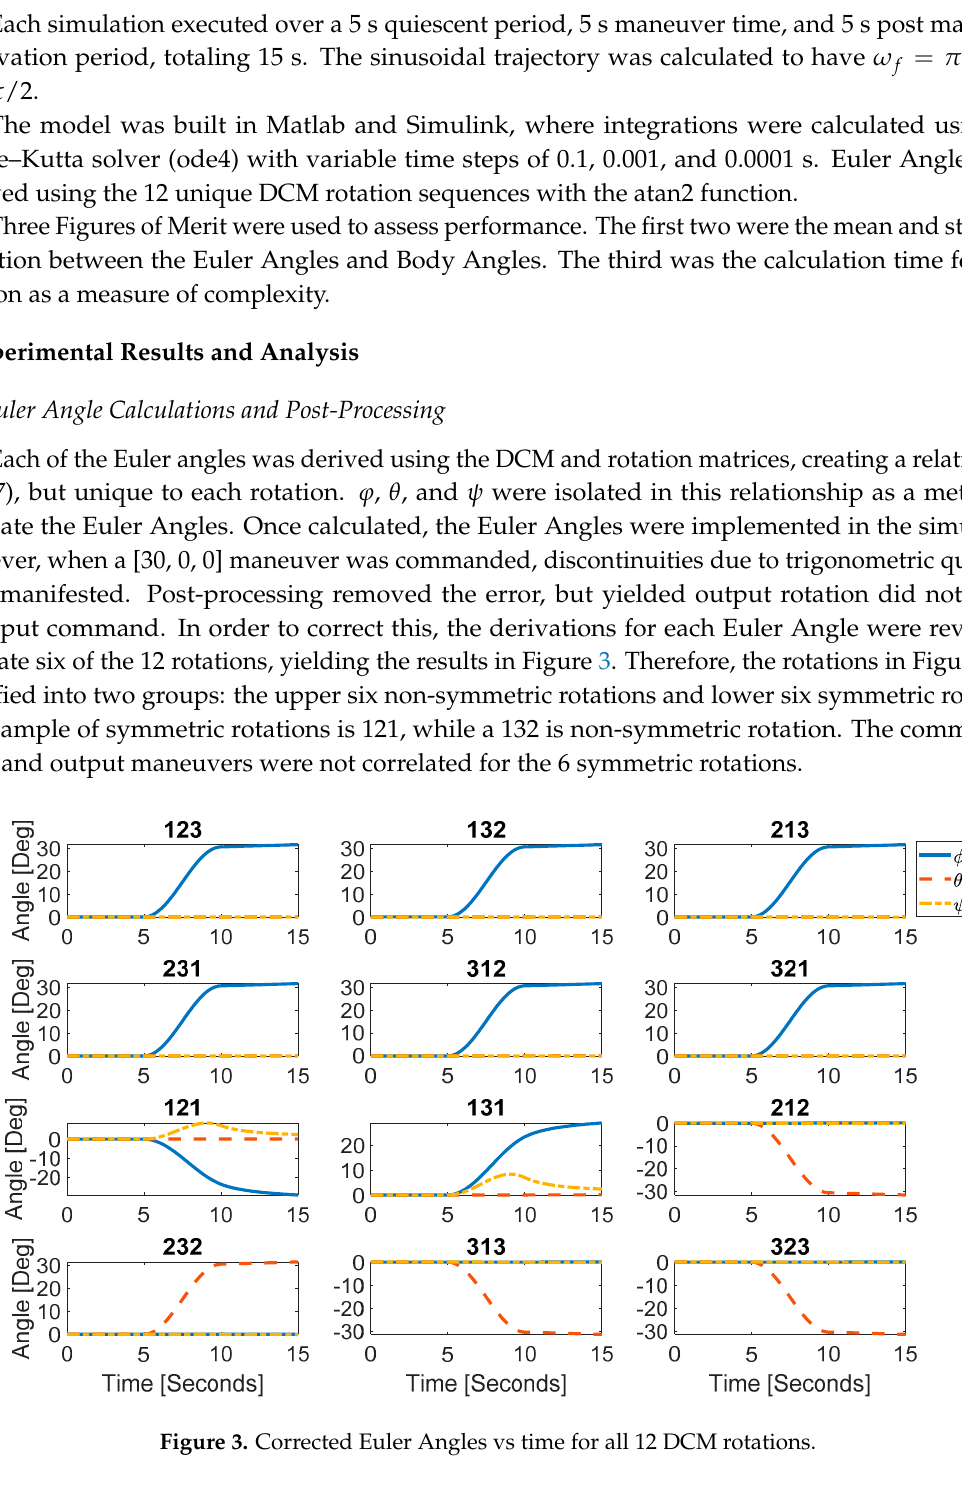
Figure 4. Euler and Body Angle deviation, using a 0.1 step size.